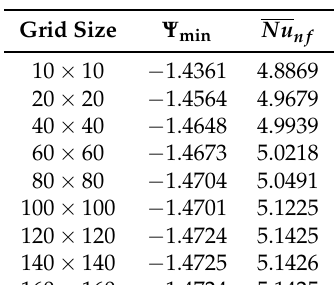
Table 1. Grid testing for Ψ min and Nu nf at different grid size for Ra = 10 5 , φ = 0.02, k w = 0.76 and D =